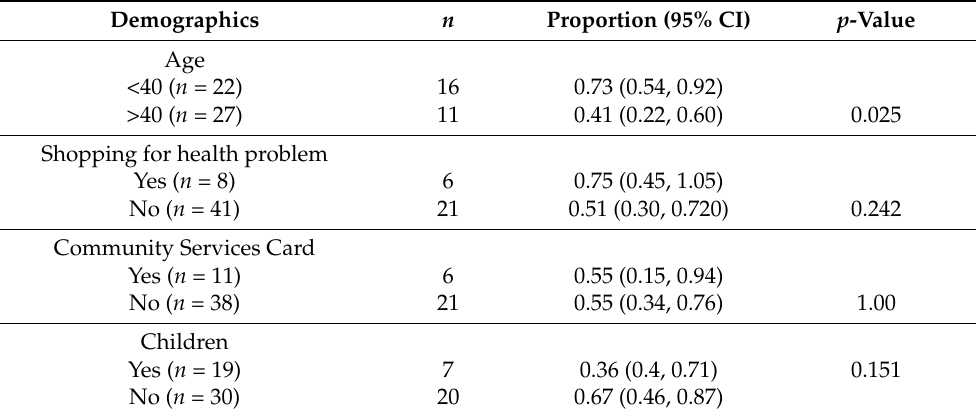
Table 3. Sub-analysis: number of participants reporting positive codes relating to nutrition content and health claims by demographic